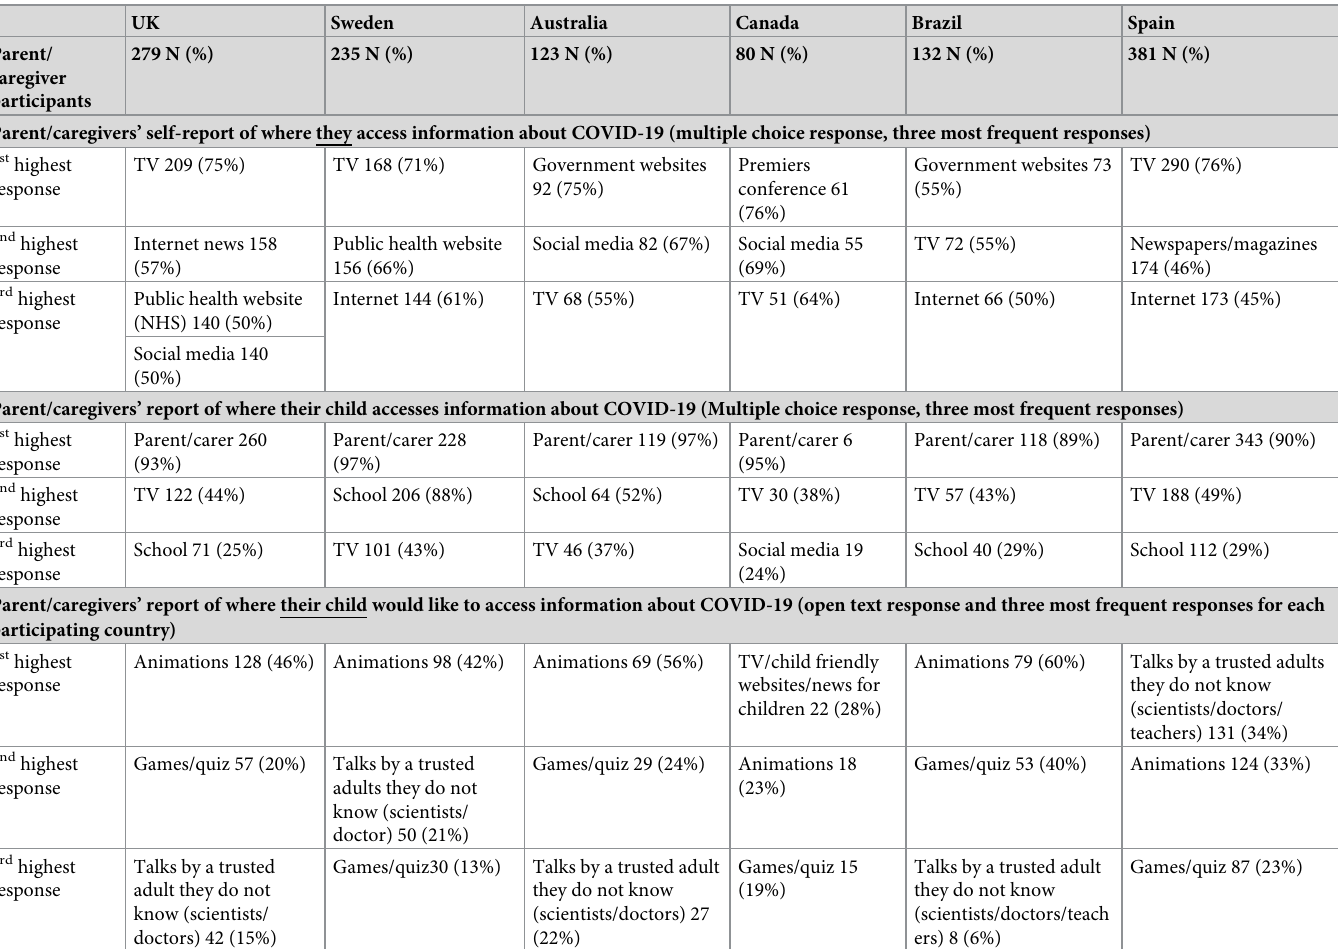
Table 5. Parents/caregivers’ self-report of where they and their child access information about COVID-19.